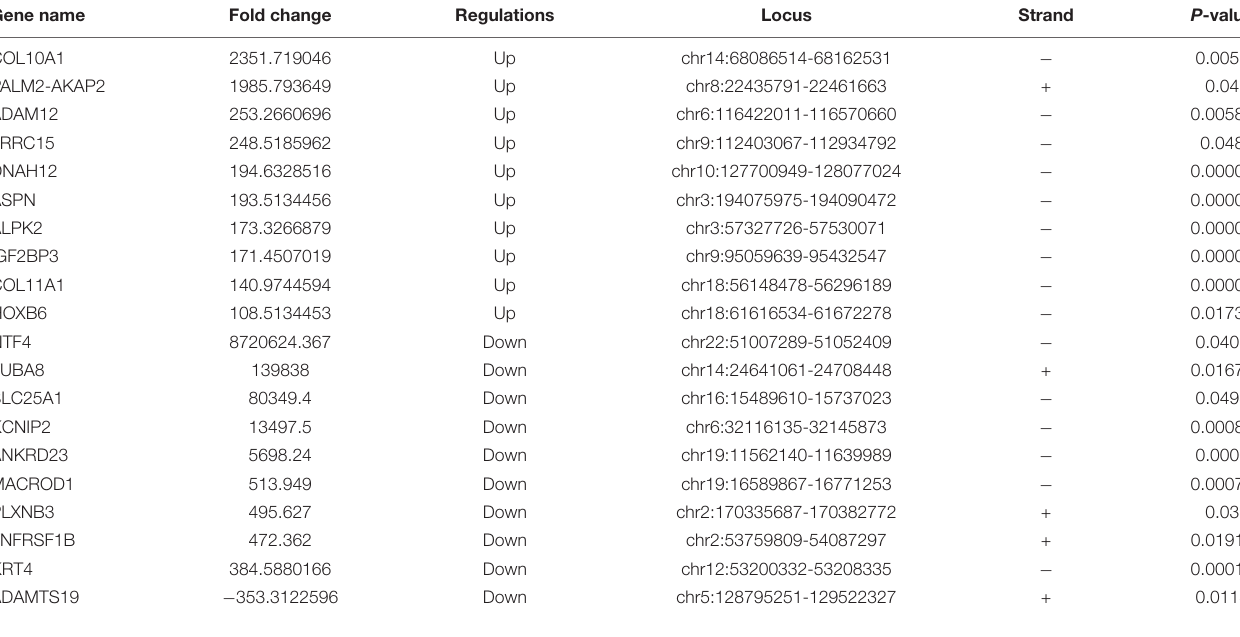
TABLE 4 | The top 20 differently expressed genes (SC vs.